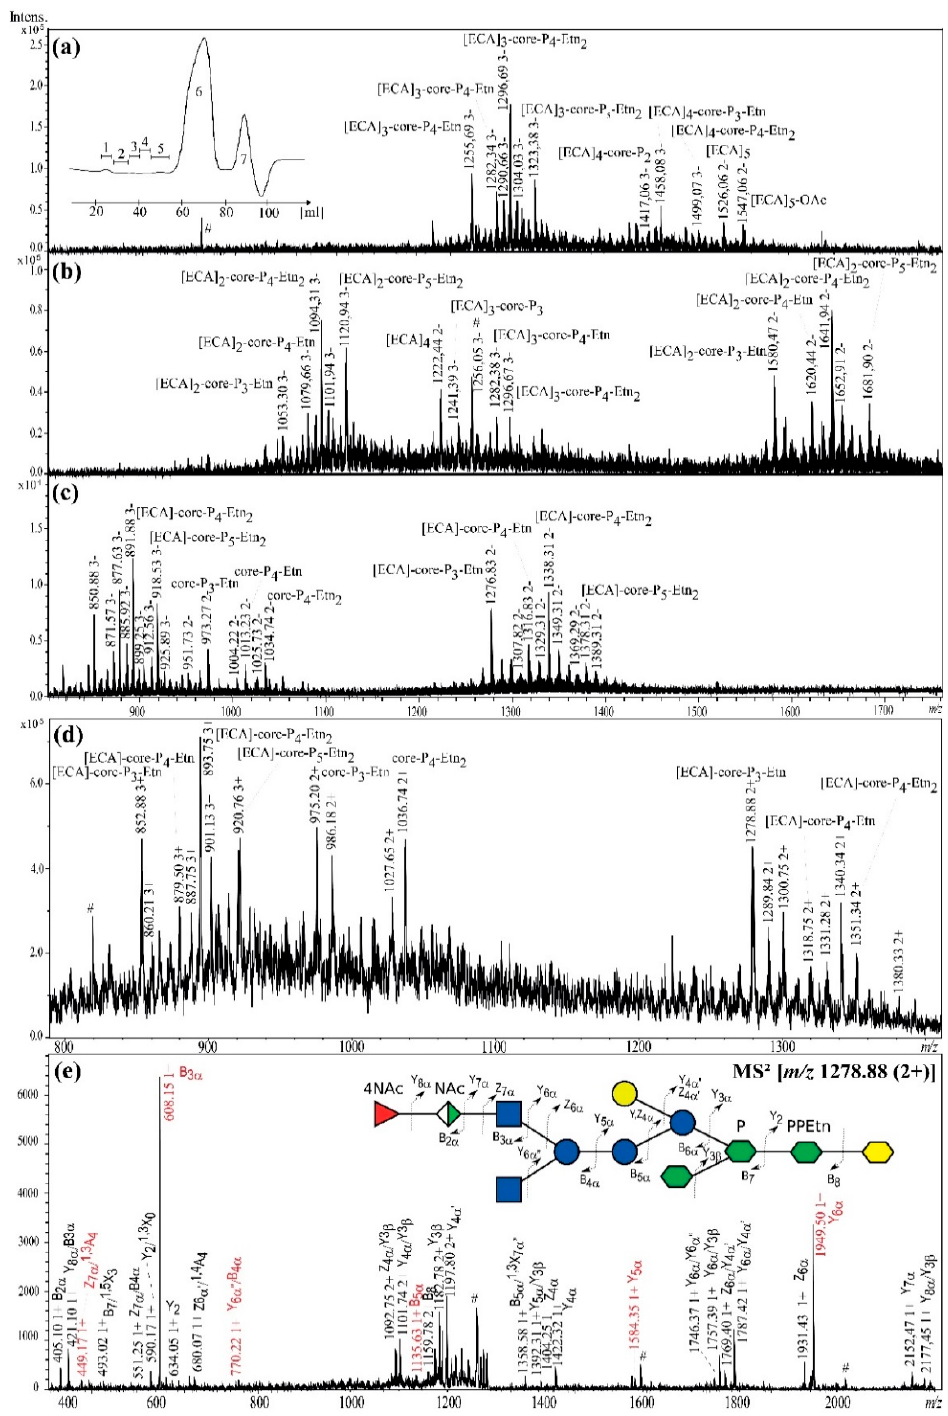
Figure 4. The ESI-MS n mass spectra of [ECA] n -core OS identified in E. coli R2 LOS preparation: ( a ) in fraction 3 (negative-ion mode), inset the Bio-Gel P-10 elution profile; ( b ) in fraction 4 (negative-ion mode); ( c ) in fraction 5 (negative-ion mode); ( d ) in fraction 5 (positive-ion mode); ( e ) Positive-ion mode ESI-MS 2 spectrum of the ion at m/z 1278.88 (+2) attributed to [ECA]-core-P 3 -Etn glycoform, where core stands for Glc 3 -GlcNAc-Gal-Hep 3 -Kdo oligosaccharide.. The interpretation of ions is shown in Table 3. The most informative ions are colored in red. The mark # stands for non-interpreted ions.